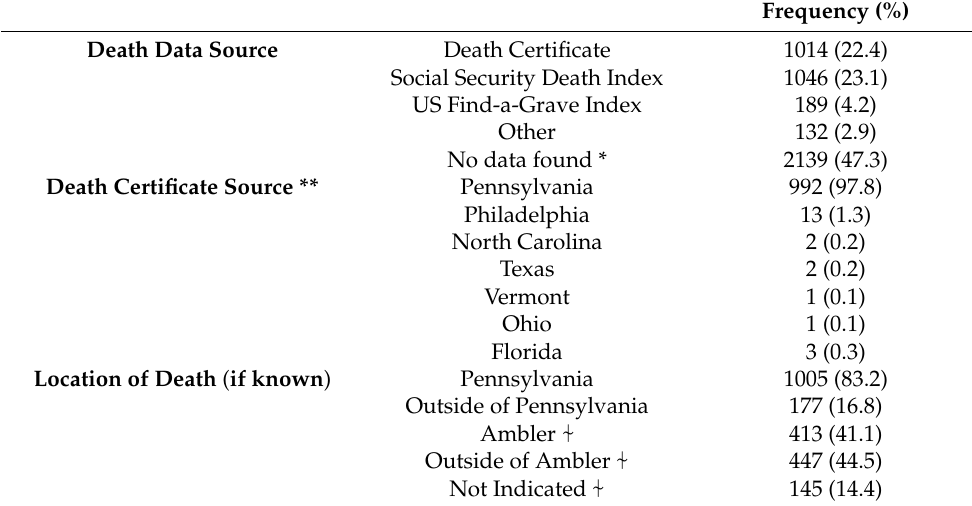
Table 3. Availability and location of death data from Ancestry.com from 1930 Ambler